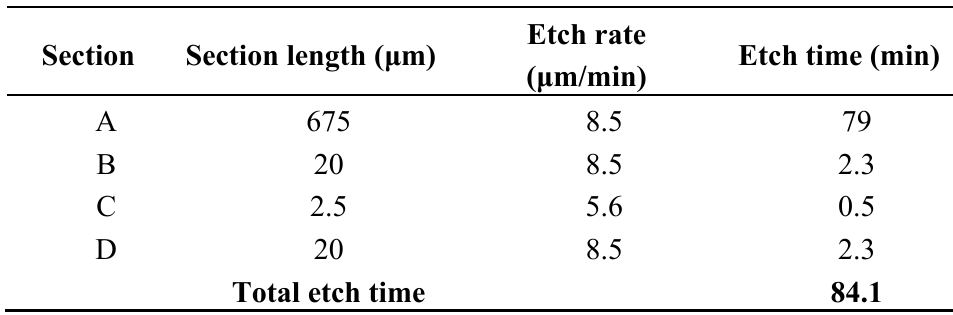
Table 1. Total etch time needed to completely release the movable elements of encapsulated MEMSTech 50g accelerometer in 5% HF